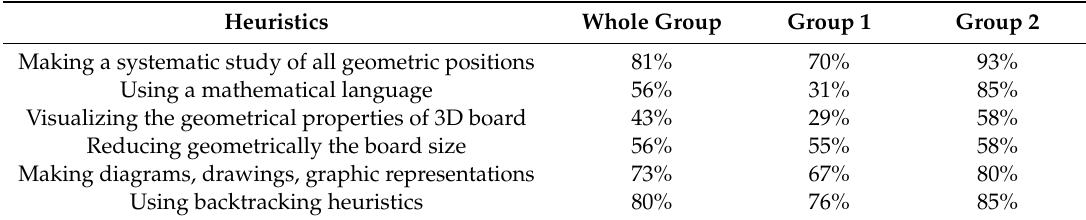
Table 2. Heuristics developed divided by academic level